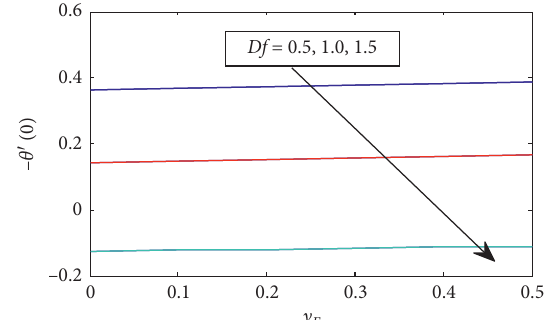
Figure 24: Local Nusselt number for different values of Df versus c